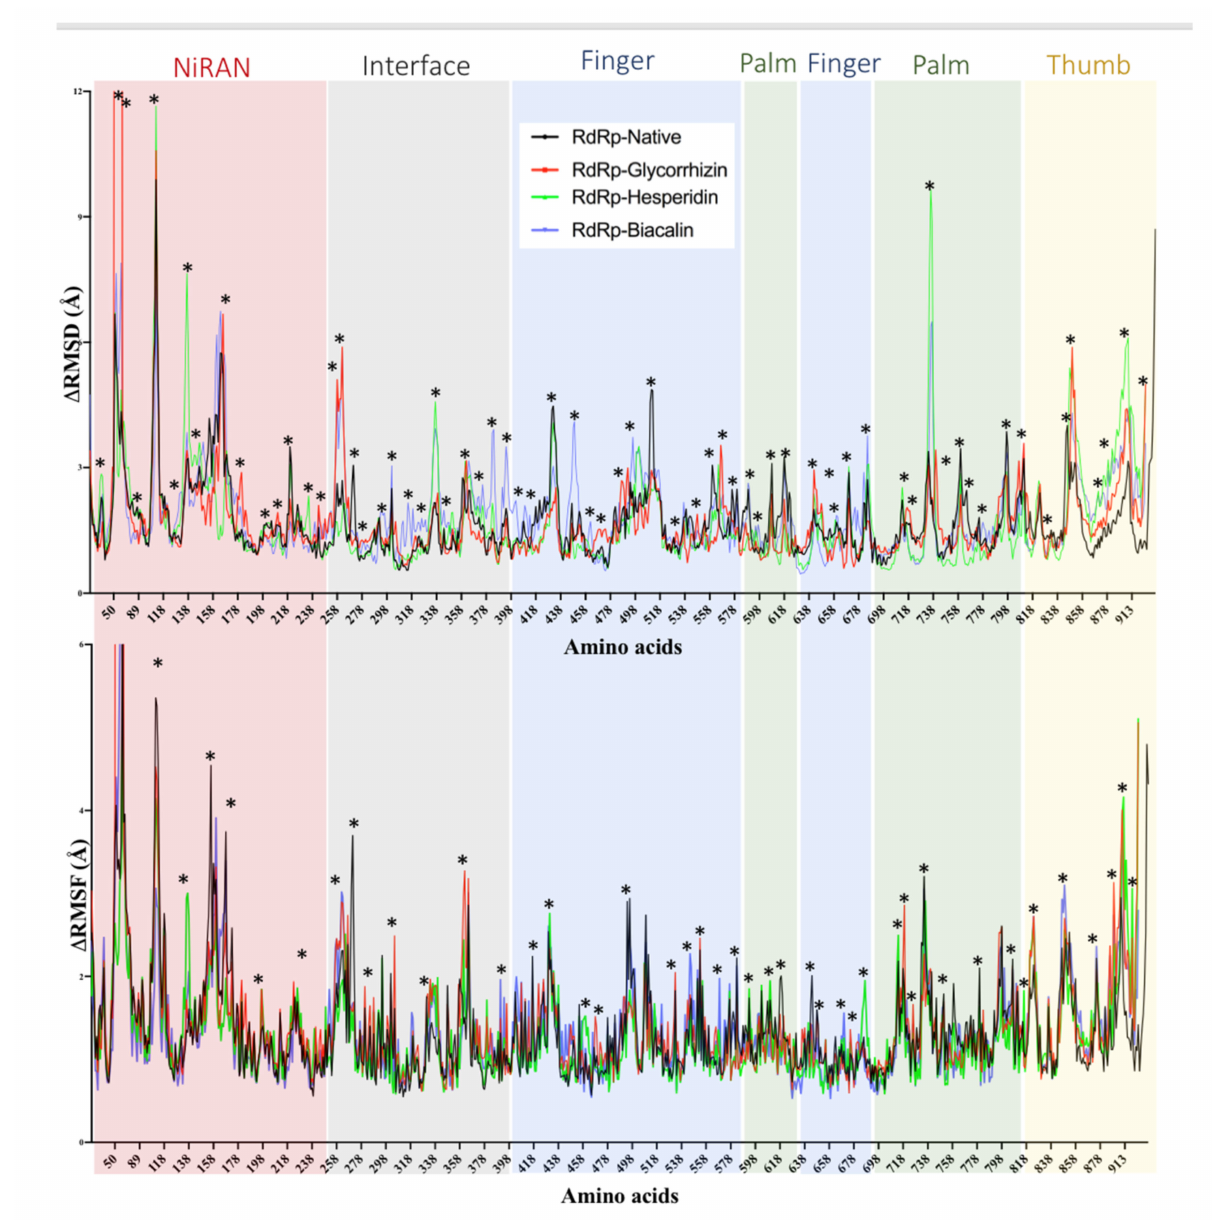
Figure 7. RMSD and RMSF calculated from molecular dynamics simulation of Glycyrrhizin (red), Hesperidin (green), Baicalin (blue) in complex with SARS-CoV-2 RdRp. The residues with dynamic RMSD and RMSF are mentioned with